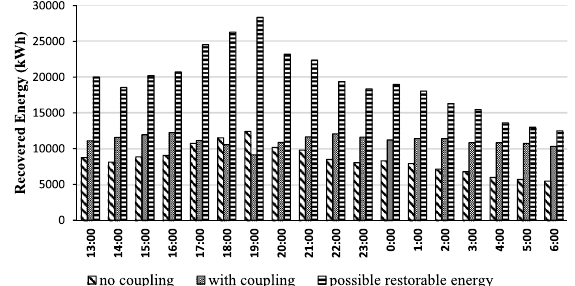
Fig. 8 Restored energy in each hour